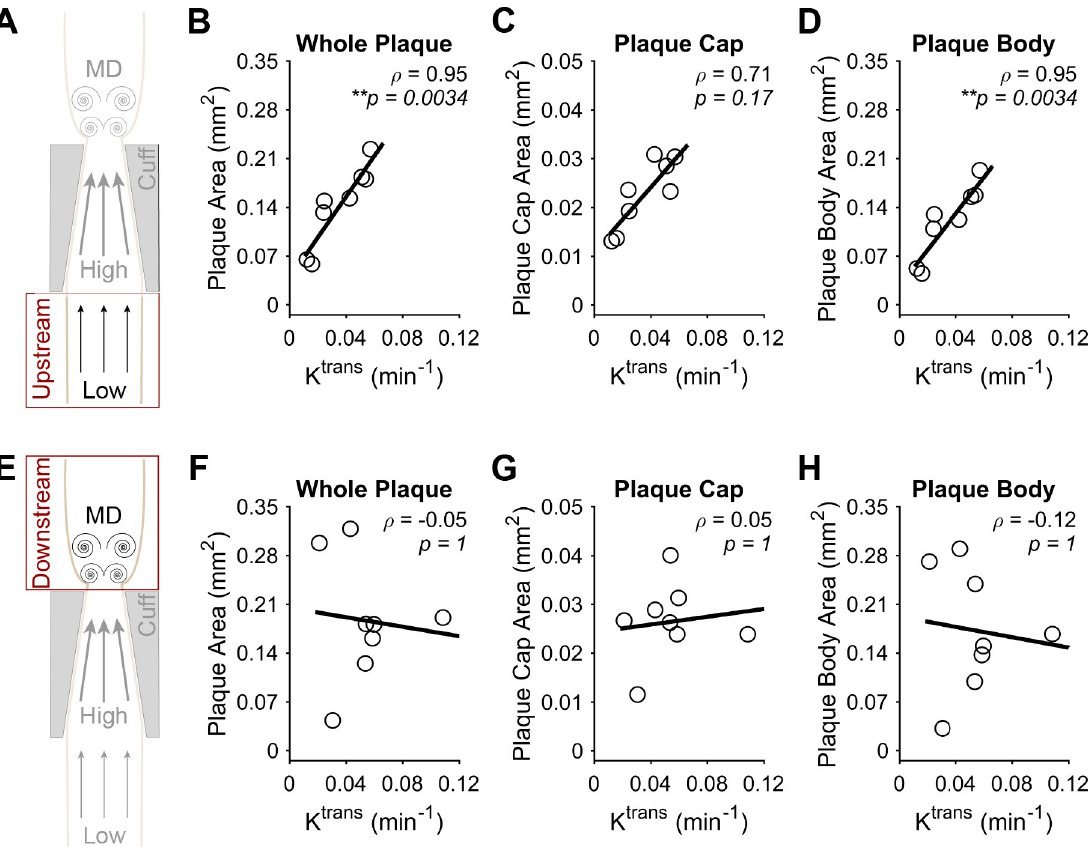
Fig 9. Correlation between plaque area and NP accumulation assessed via K trans at 9 weeks after cuff placement. (A) Diagram of the instrumented carotid artery highlighting the focus of this part of the figure on the low WSS (upstream) region. (B-D) The correlation between plaque area and K trans in different regions of the plaques induced by low WSS, including the (B) entire plaque, (C) plaque cap (13.3 μ m), and (D) plaque body minus the cap. (E) Diagram of the instrumented carotid artery highlighting the focus of this part of the figure on the multidirectional WSS (downstream) region. (F-H) The correlation between plaque area and K trans in different regions of the plaques induced by multidirectional (MD) WSS, including the (F) entire plaque, (G) plaque cap (13.3 μ m), and (H) plaque body minus the cap. Each data point of each plot represents the mean plaque area across all histological sections associated with a DCE-MRI slice, from which K trans was obtained (in mice with viable histological sections associated with more than one DCE-MRI slice, more than one pairing was used; all mice injected with NPs ( n = 5) are represented in all plots). The black line in each plot represents a linear regression of the data to visualize the trend. Spearman’s correlation coefficient, ρ , and associated p -value are also given. � P < 0.05 is considered statistically